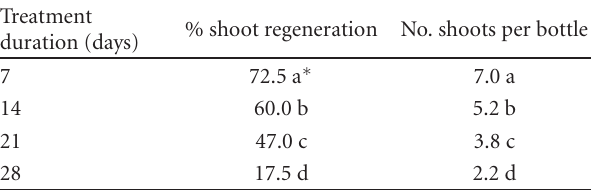
Table 3: Comparison of the e ff ect of duration of 120mg/L colchicine treatment on shoot regeneration from petiole explants.